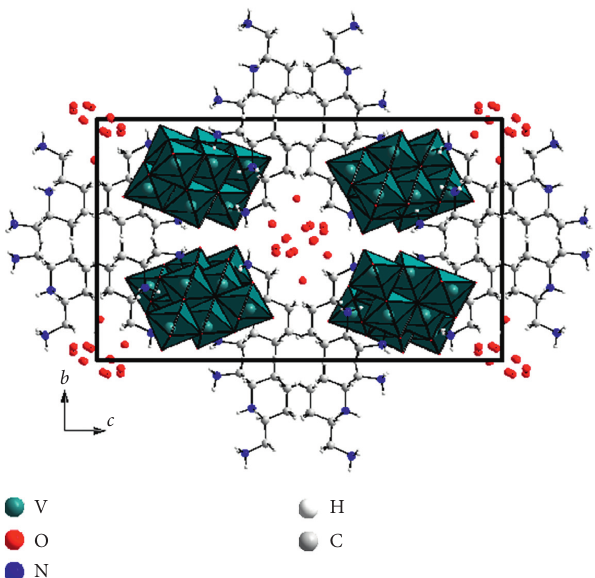
Table 2: Distortion, indexes (ID), and BVS calculations for (C Octahedra V1O